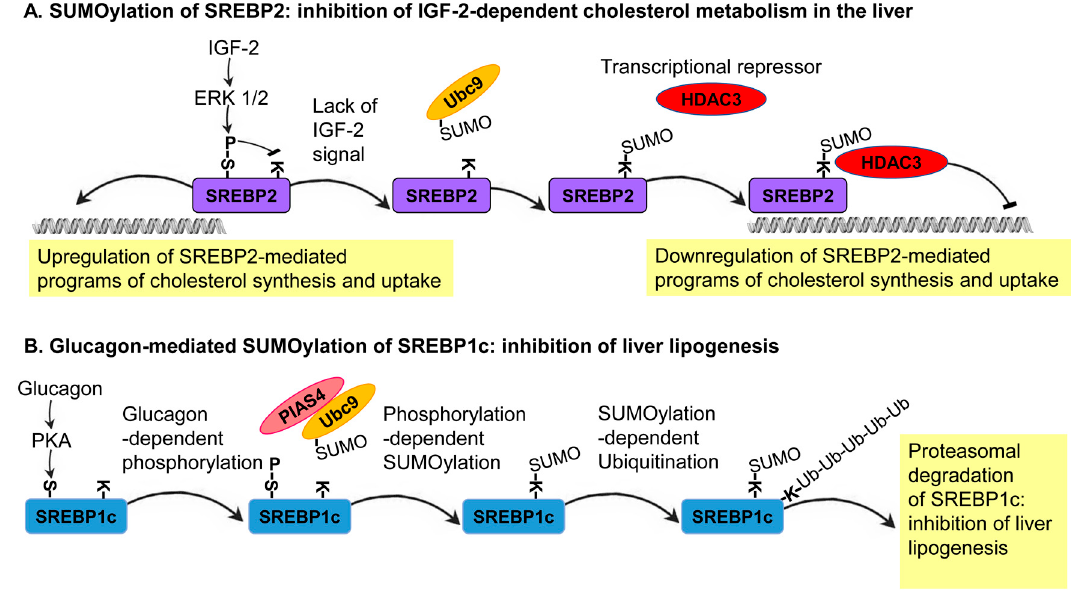
Figure 3. Two prominent cases of the regulation of SREBP-dependent lipid metabolism by SUMOylation: ( A ) In specific physiological conditions, the hormone Insulin-like Growth Factor 2 (IGF-2) activates two mitogen-activated protein kinases, ERK1 and ERK2, in order to phosphorylate SREBP2. This regulated phosphorylation reduces the level of SREBP2 SUMOylation, thus, leading to the upregulation of genes that encode enzymes of sterol metabolism, including the LDL receptor (LDLR), squalene synthase, and HMG-CoA synthase [28]. In the absence of the IGF-2 signal, SREBP2 SUMOylation leads to the inhibition of the transcriptional activity of SREBPs through the recruitment of a corepressor complex that includes the histone deacetylase 3 (HDAC3) [28]. ( B ) In fasting conditions, the secretion of the mouse fasting hormone, glucagon, from the pancreas activates Protein Kinase A (PKA), which phosphorylates SREBP1c on serine 308. This phosphorylation increases the levels of SREBP1c SUMOylation, leading to its ubiquitination-dependent degradation. SREBP1c degradation results in the inhibition of lipogenesis in order to switch the metabolic state of the organism toward catabolism [33]. This mechanism was further elucidated by the overexpression of the SUMO E3 ligase, PIAS4, in obese db / db mice, which leads to the inhibition of lipid synthesis. Moreover, the suppression of PIAS4 activity in lean mice triggers the expression of SREBP1c target genes that stimulate hepatic lipogenesis [33].